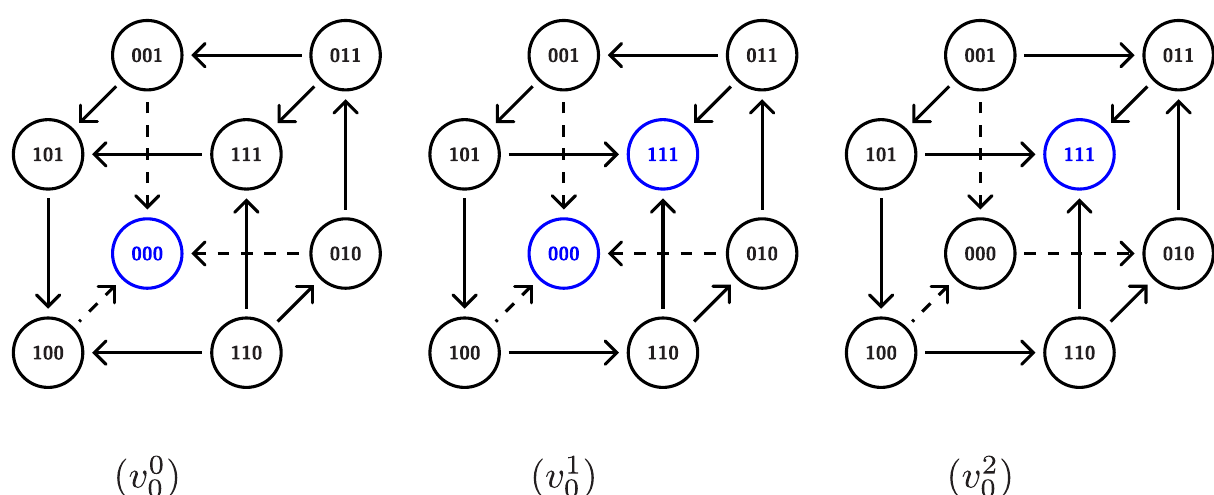
Fig 6. Hysteresis representation in DSGRN. State transition graph for Network 1 in Fig 3 over a factor graph PG (0) at the unique essential node of PG (1) × PG (2). ( v 0 ) represents a low input to node 0 and exhibits FP (0, 0, 0); ( v 1 0 (0, 0, 0) and FP (1, 1, 1); ( v 2 ) represents a high input to node 0 and exhibits FP (1, 1, 0